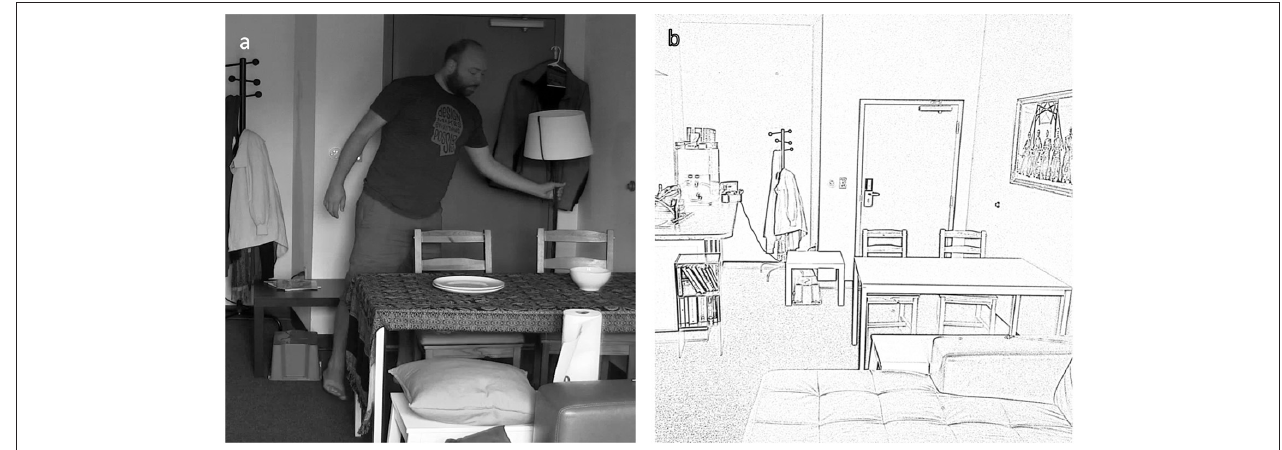
FIGURE 5 | Still picture from a stimulus clip (a) and picture for the matcher’s drawing (b)